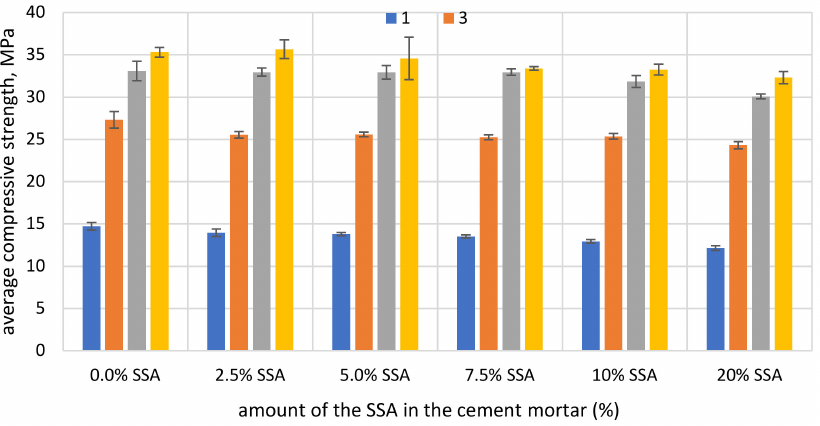
Figure 7. Average compressive strength of the cement mortar without and with